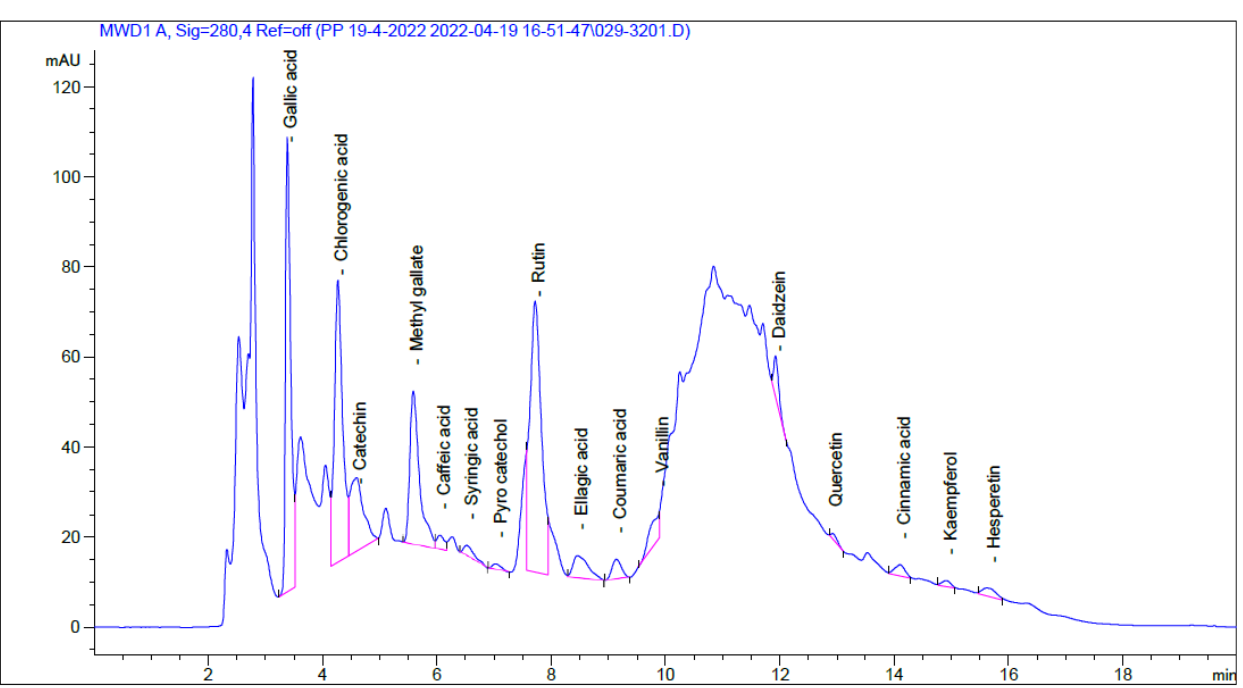
Figure 1. Chromatogram for the identified molecules of SCRE. Table 1. Analysis of the phenolic and flavonoid components of SCRE using